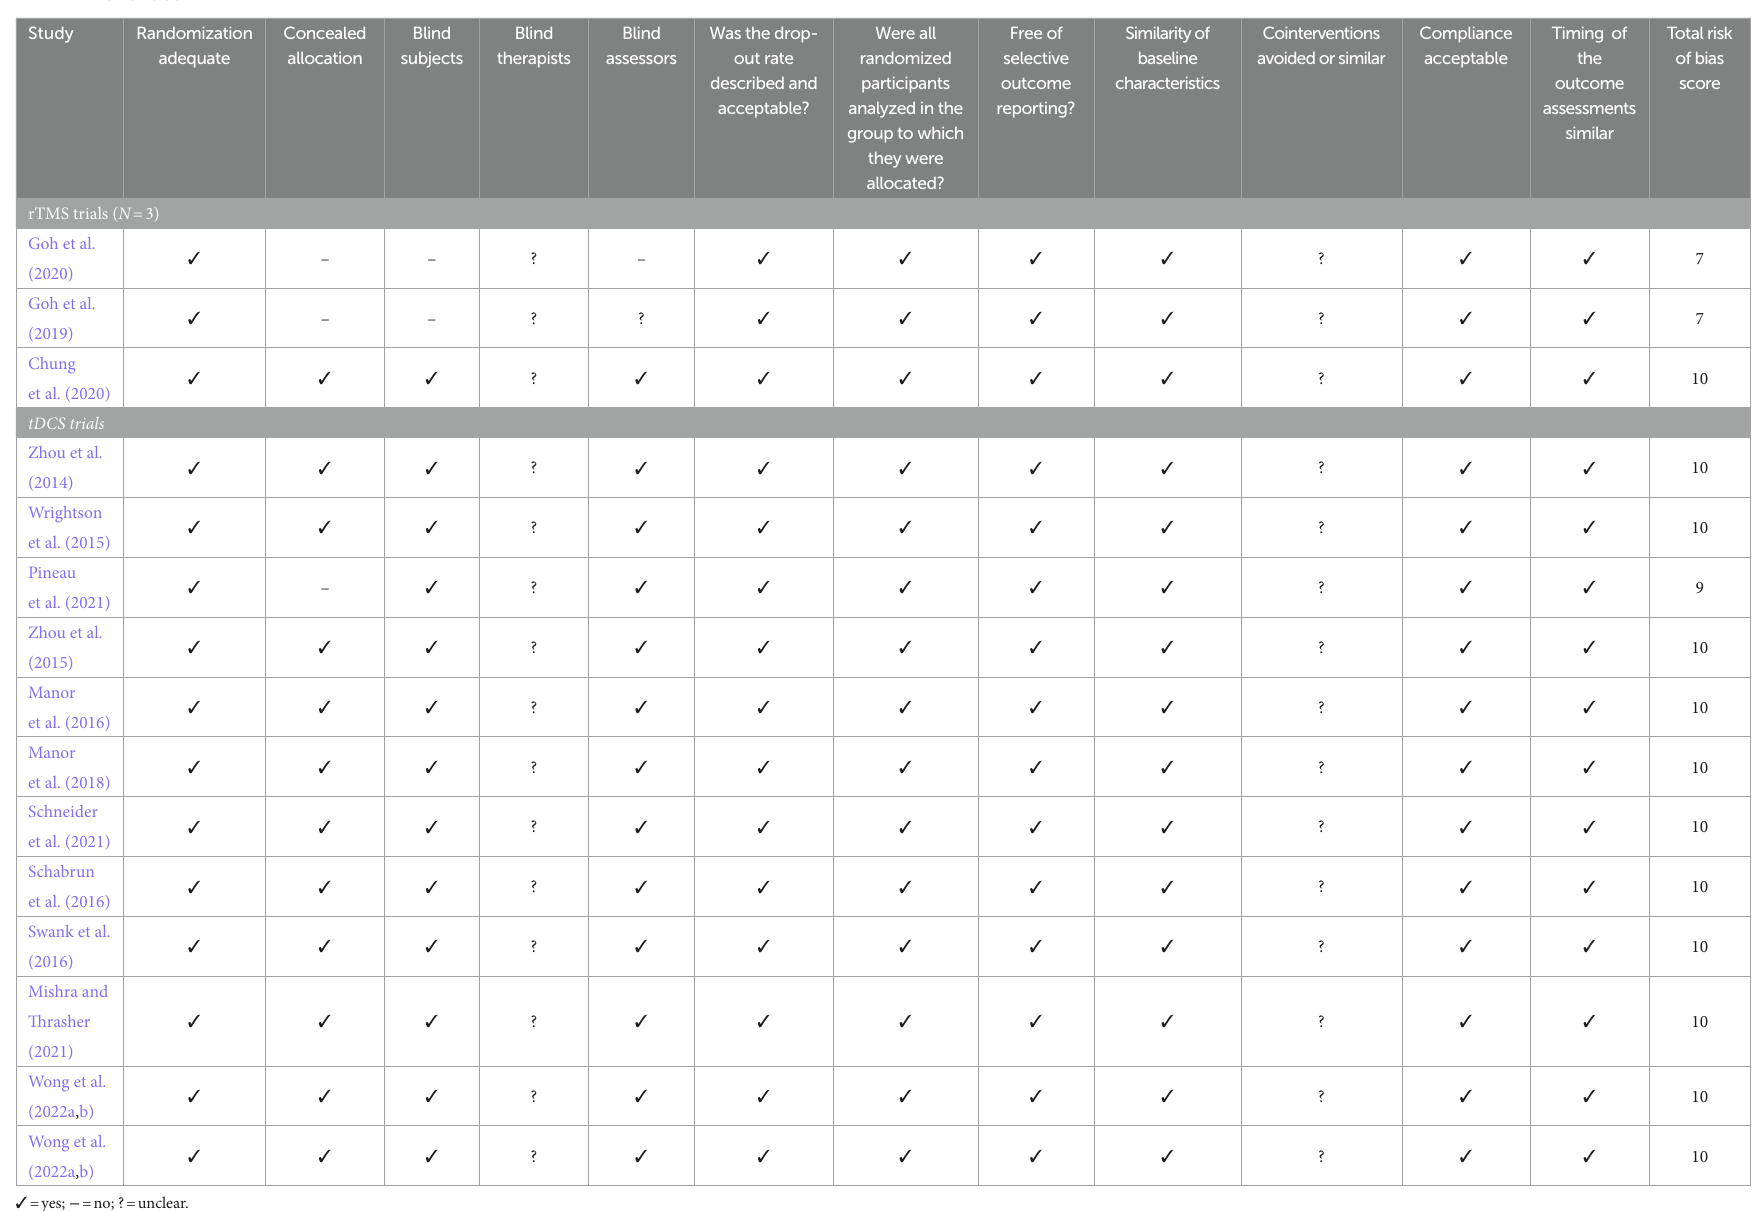
TABLE 1 Risk of